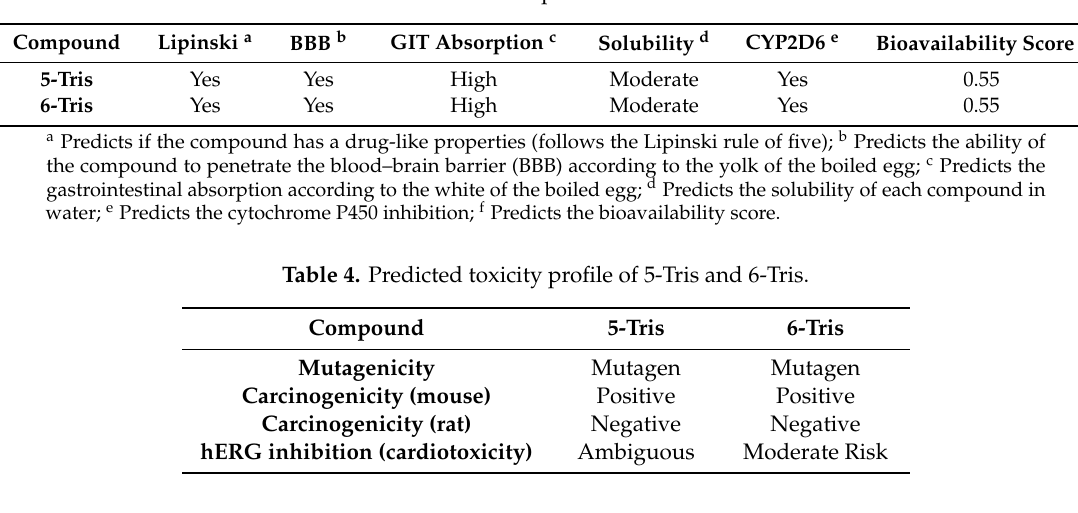
Table 3. Predicted ADME profiles of 5-Tris and 6-Tris.